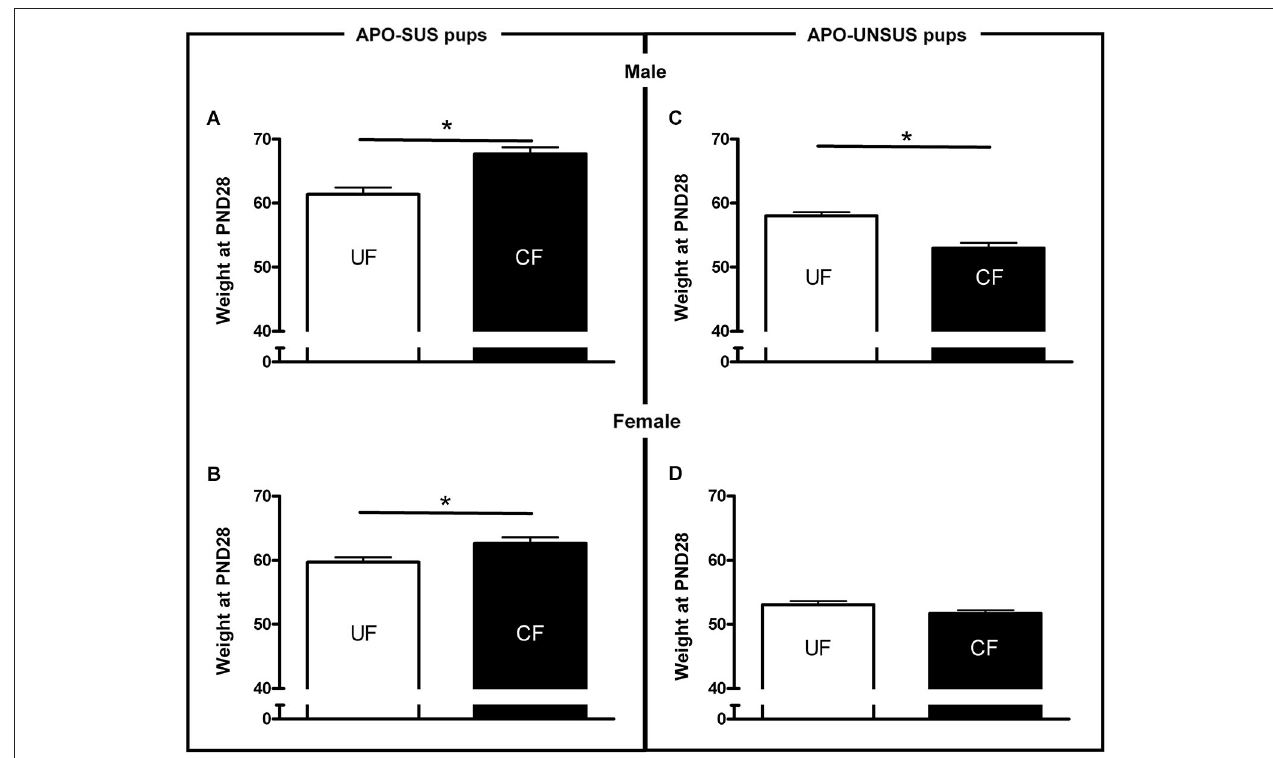
FIGURE 2 | Weights at PND 28 of male (A) and female (B) APO-SUS, as well as male (C) and female (D) APO-UNSUS pups after being unfostered (UF; white bars) or cross-fostered (CF; black bars). * p < 0.05.